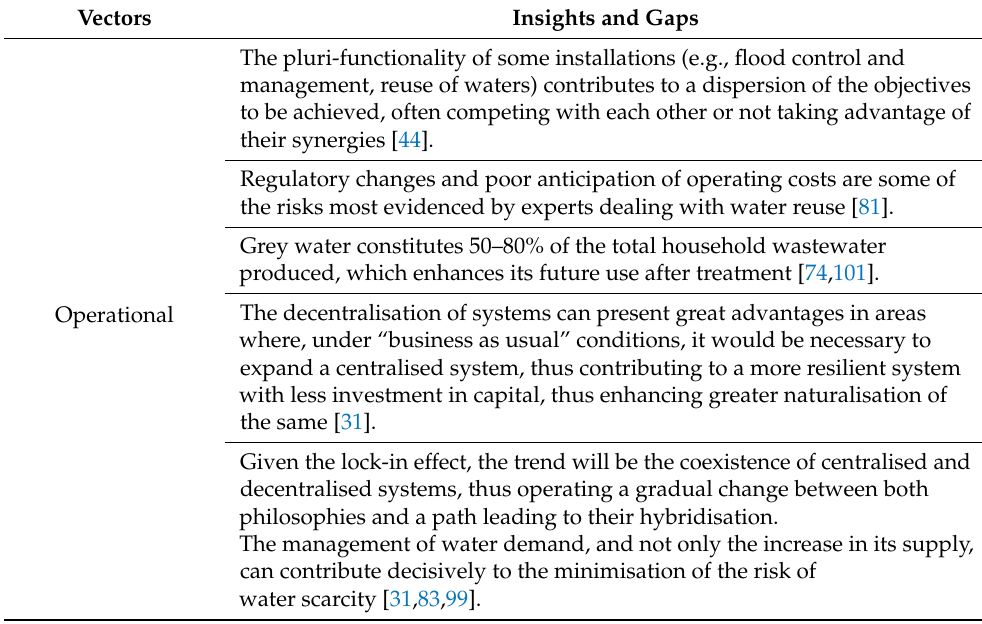
Table 5. Synthesis of the main insights and gaps that arise from the literature